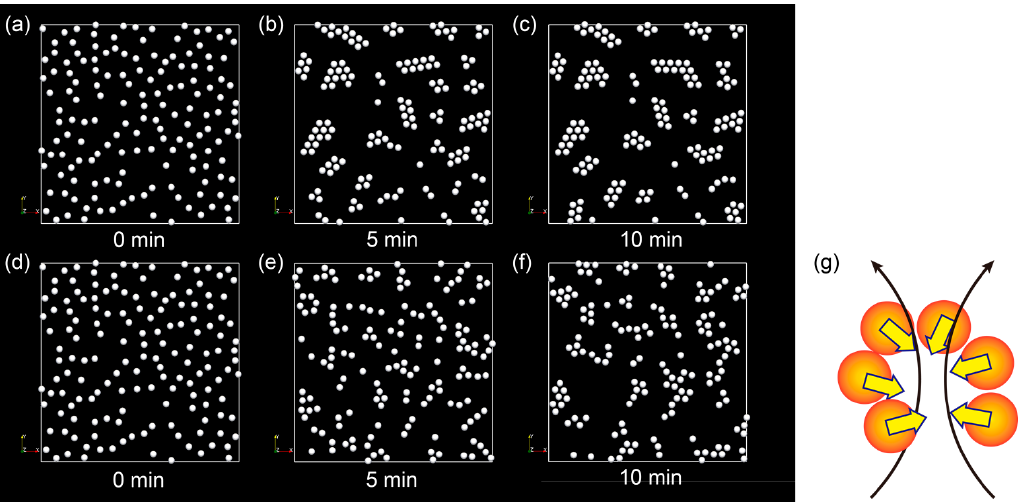
Figure 3. Effects of hydrodynamic interactions: ( a – c ) Langevin dynamics simulation (without hydrodynamic interactions); and ( d – f ) fluid particle dynamics simulation (including the effects of long-range hydrodynamic interactions); ( g ) Schematic showing the deceleration of chain folding. To form the spherical cluster, it is necessary to squeeze the fluid surrounding cells, which slows the dynamics of the interactions. This dynamic selection supports the chain-like nature of clusters, despite the observation that the most stable structure is the spherical cluster.